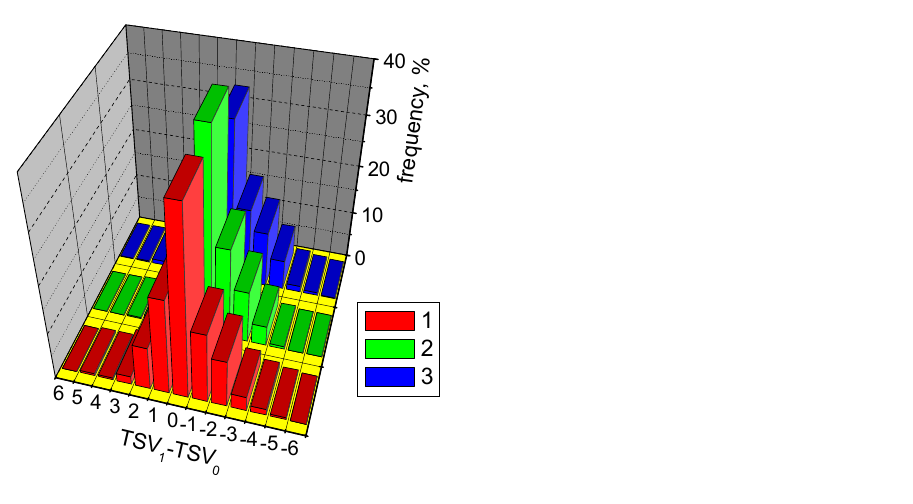
Figure 16. Changes of thermal sensation vote during the measurements in the Courthouse (1), “A” building (2) and “Energies” (3).